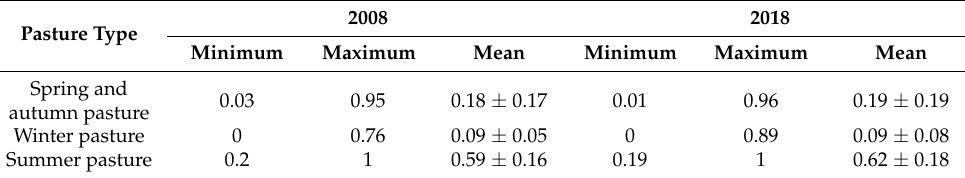
Figure 2. The spatial distribution of MODEI level in 2008 and 2018. Table 5. MODEI of different seasonal